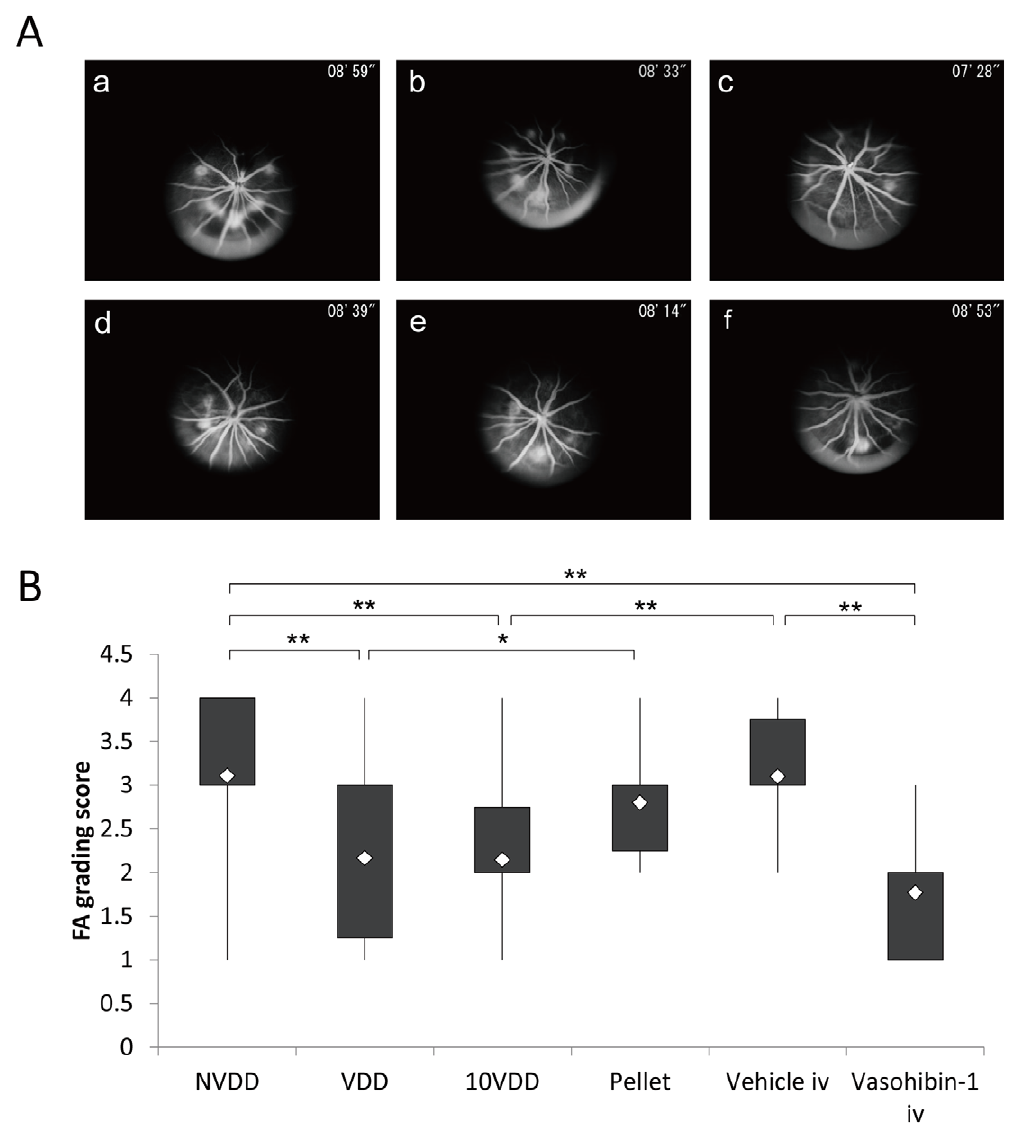
Figure 5. Fluorescein angiography 2 weeks after CNV laser procedure. (A) Representative results of fluorescein angiography in each group at 2 weeks after CNV laser procedure. The groups were treated with NVDD (a), VDD (b), 10VDD (c), vasohibin-1 pellet (d), intravitreal vehicle injection (Vehicle iv) (e), intravitreal vasohibin-1 injection (Vasohibin-1 iv) (f). (B) Significantly lower FA scores was shown in the Vasohibin-1 iv group when compared to those of NVDD (p=0.000022), and Vehicle iv (p=0.0065). Significantly lower FA scores are also observed in the 10VDD group when compared to the NVDD group (p=0.00003) and intravitreal vehicle injection (p=0.011). Significant differences are shown as asterisks. NVDD: non- vasohibin-1 (vehicle) delivery device, VDD: 1 m M vasohibin-1 delivery device, 10VDD: 10 m M vasohibin-1 delivery device, Pellets: vasohibin-1 pelletized at the same concentration of 10VDD (without reservoir and cover).